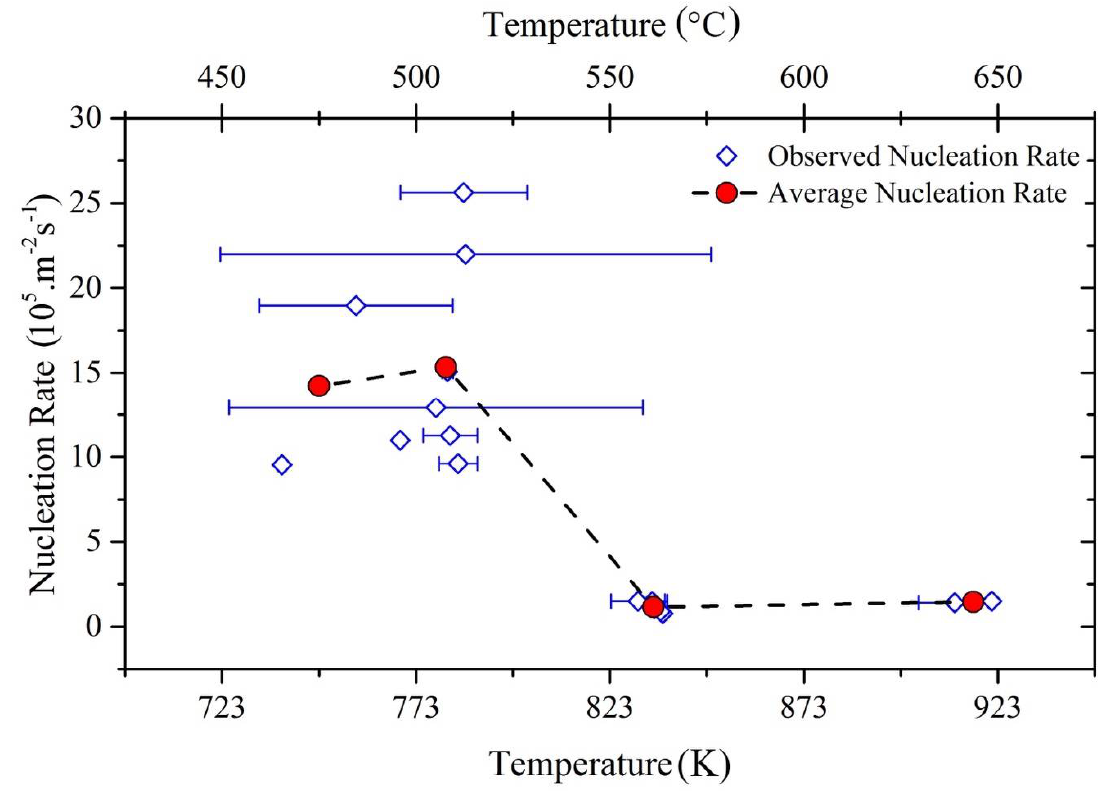
Figure 13. Temperature dependence on the average nucleation rate per unit area.